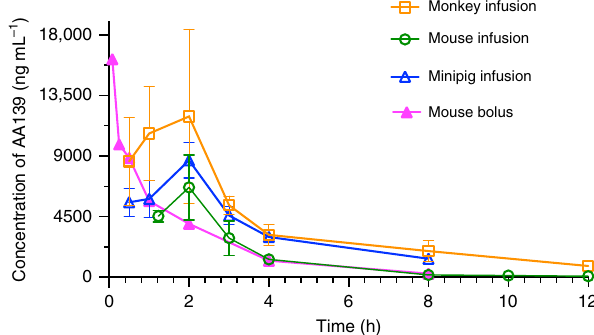
Fig. 6 The pharmacokinetic pro fi le across species of systemically administered AA139. Plasma or serum AA139 concentration in mouse, monkey and minipig over time after the initiation of a 10 mg kg − 1 dose (i.v. continuous infusion over 2 h, or i.v. single bolus injection). Mean values with error bars shown as SEM (mouse i.v. infusion n = 6, mouse i.v. bolus n = 3, monkey n = 2, minipig n = 2; male and female combined for all species) are plotted using Prism 8. Source data are provided as a